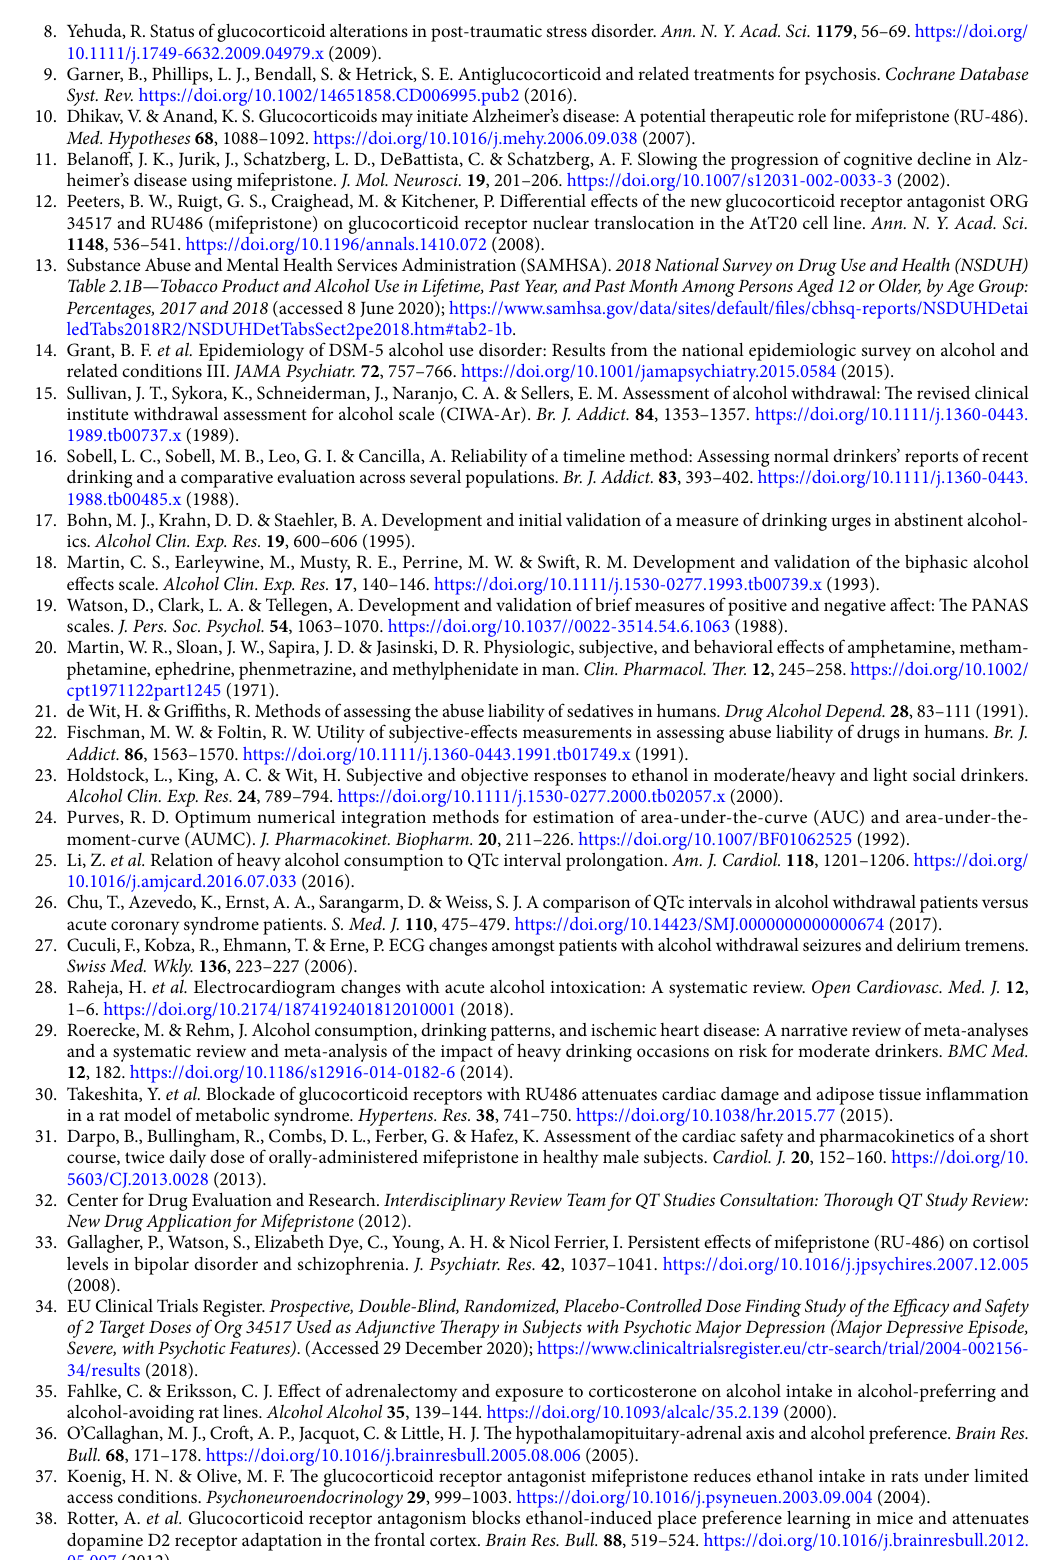
Table 2.1B—Tobacco Product and Alcohol Use in Lifetime, Past Year, and Past Month Among Persons Aged 12 or Older, by Age Group: Percentages, 2017 and 2018 (accessed 8 June 2020); https:// www. samhsa. gov/ data/ sites/ defau lt/ files/ cbhsq- repor ts/ NSDUH Detai ledTa bs201 8R2/ NSDUH DetTa bsSec t2pe2 018. htm# tab2- 1b. 14. Grant, B. F. et al. Epidemiology of DSM-5 alcohol use disorder: Results from the national epidemiologic survey on alcohol